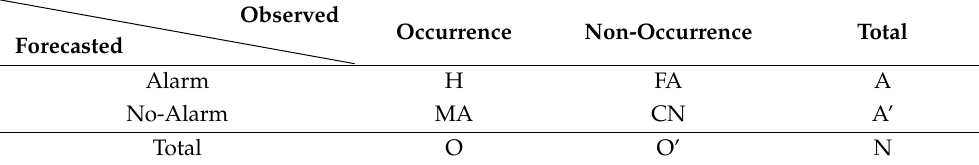
Table 6. Contingency table for ROC curve. Observed Occurrence Non-Occurrence Total Forecasted Alarm H FA A No-Alarm MA CN A’